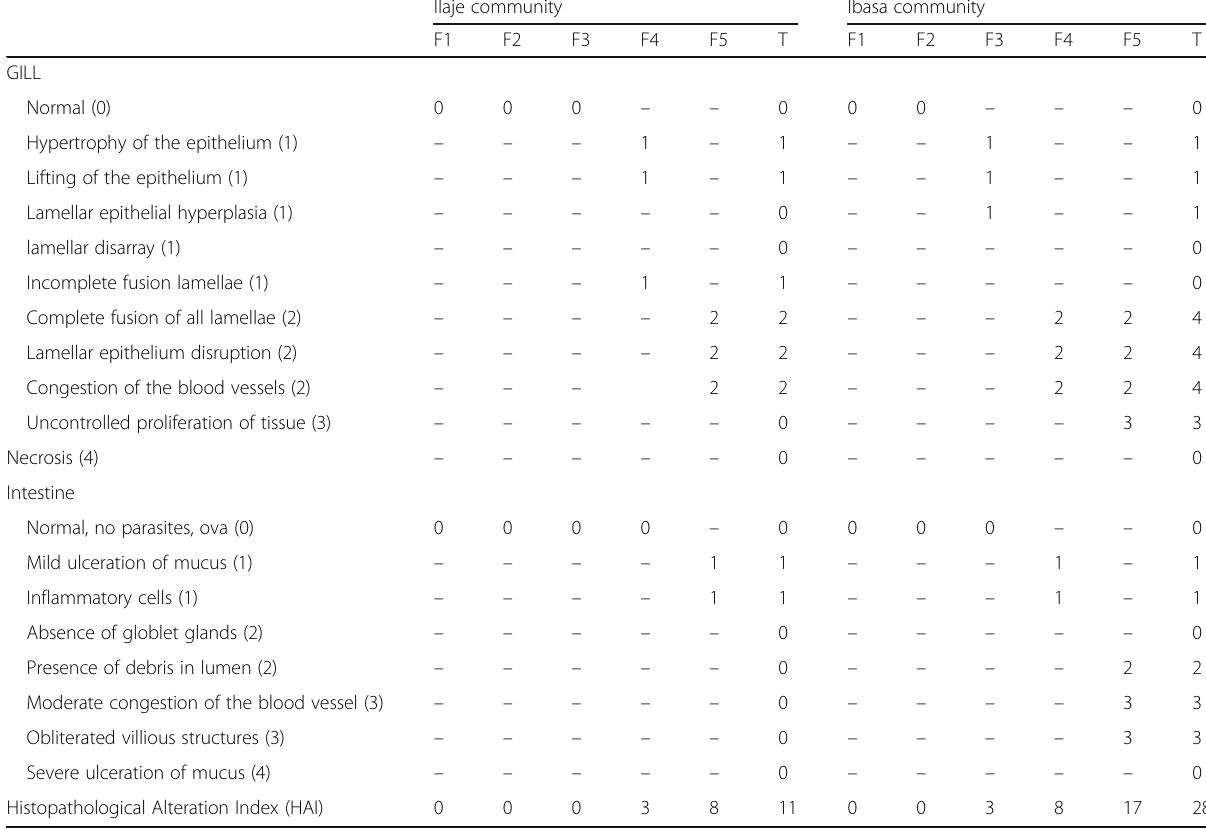
Table 12 Histopathological Alteration Index in Ibasa and Ilaje communities, Snake Island,